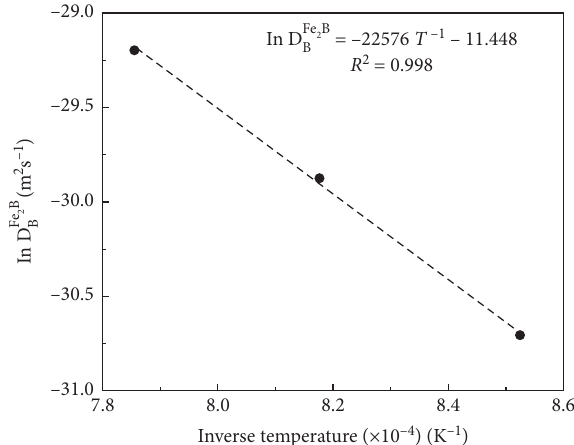
Figure 8: The behavior of the boron diffusion coefficient as a function of the boriding temperature. Table 2: Comparison of the boron activation energy for some materials depending on the boriding method. Material